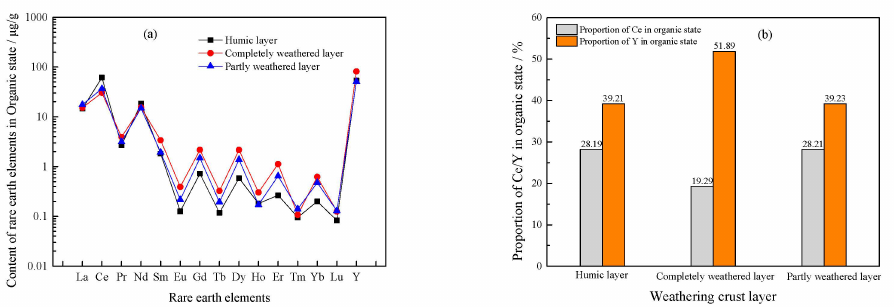
Figure 10. Organic binding state of the weathered crust elution-deposited rare earth ore. ( a ) Content of the organic bound state rare earth elements in each weathered layer; ( b ) Proportion of Ce and Y in organic bound state in each weathered